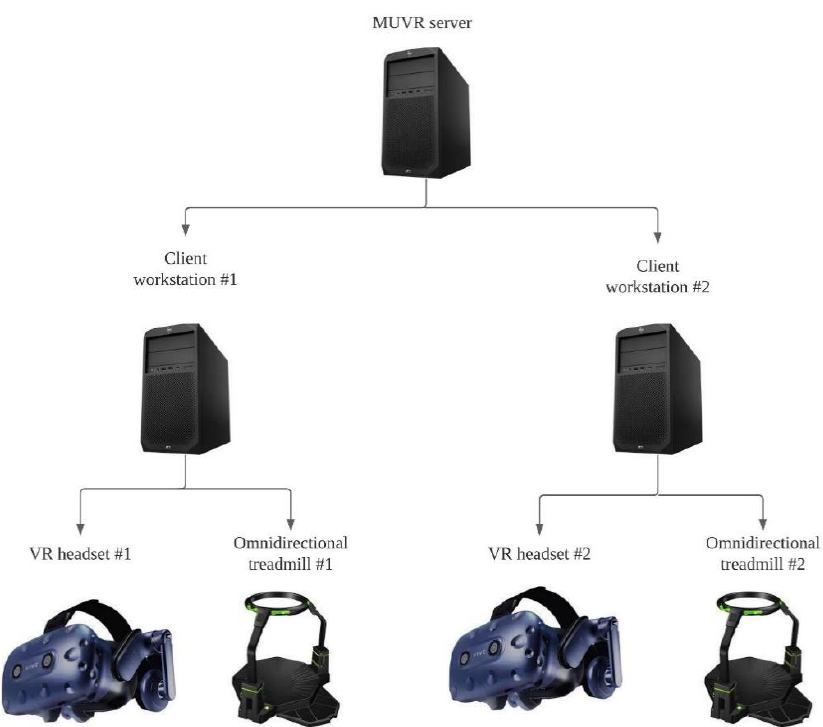
Figure 3. Client–server architecture of the Figure 3. Client – server architecture of the system.